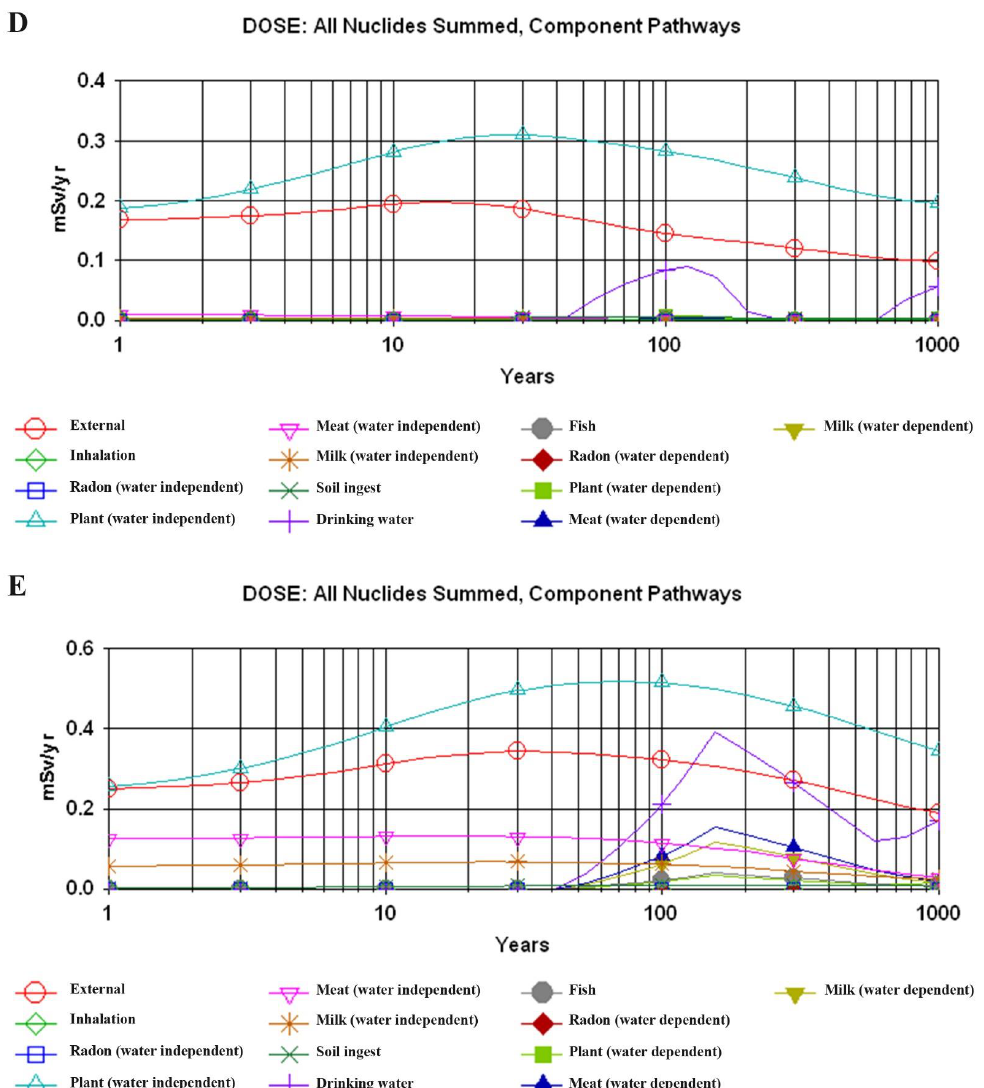
mobilization and availability of these progenies. The magnitude of change varies from one landfill to another. The highest risks are Ra-226 for coal slag (1.76 × 10 −2 ), Th-232 for Figure 3. Contribution of different exposure pathways to total dose. ( A ) Ajka coal, ( B ) Ajka red mud, Figure 3. Contribution of different exposure pathways to total dose. ( A ) Ajka coal, ( B ) Ajka red mud, red mud (3.45 × 10 −3 ), and K-40 for manganese (2.87 × 10 −3 ). For drilling mud reservoirs, ( C ) Almásfüzitő red mud, ( D ) Zalatárnok drilling mud, ( E ) Ú rkút manganese. thorium and potassium are the dominant nuclides, with the nuclide posing the greater ( C ) Alm á sfüzit˝o red mud, ( D ) Zalat á rnok drilling mud, ( E ) Ú rk ú t manganese. risk varying with time. Figure 4 shows cancer risk estimated by the REDRAD-ONSITE code. The shape of the curve is similar for all storage. Initially, there is a growth phase with a maximum be- tween 100 and 200 years (in the range of 4.15 × 10 −4 to 1.81 × 10 −2 for total risk). This is followed by a fall and then a rise again at the end (t = 1000 years). Since the modelling considers the radiation exposure and risk from decay products, the increase is due to the